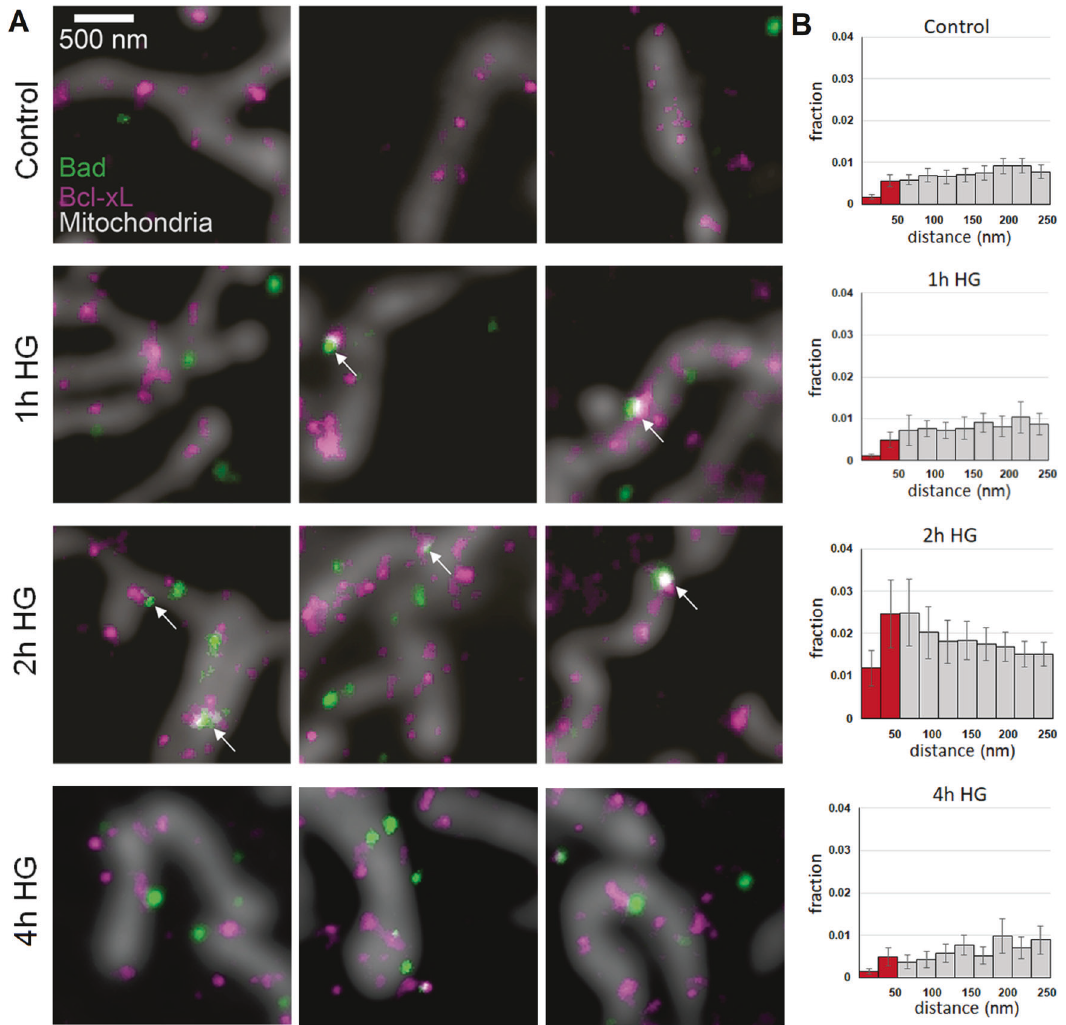
Fig. 3 Bad translocates toward mitochondrial Bcl-xL in proximal tubular cells (PTCs) upon high glucose (HG) treatment. A Representative stimulated emission depletion (STED) images showing the distributions of Bad (green) and Bcl-xL (magenta) in PTCs treated with HG or 5.6 mM glucose (Control) together with confocal images of mitochondria (gray). Arrows indicate colocalization of proteins. B Nearest neighbor analysis of the data presented in A . N = number of micrographs from different cells obtained from 3 or more cell culture preparations; 56 in control, 62 in 2 h HG, and 26 in 4 h